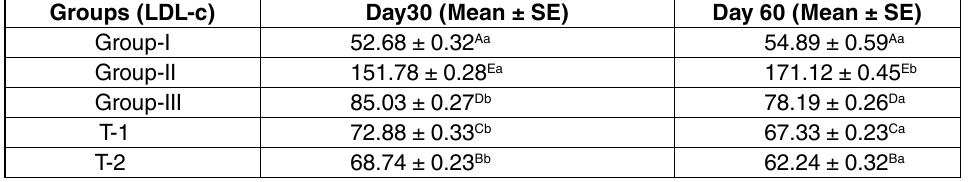
table 8. The mean ± SE serum LDL-cholesterol (mg/dl) values in different treatment groups.